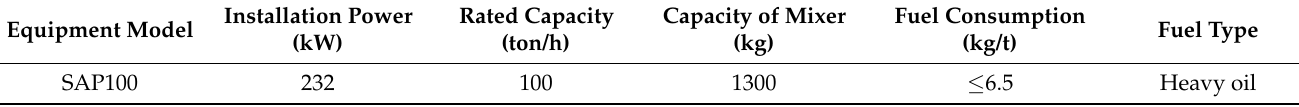
Table 2. Characterization of asphalt mixing plant.